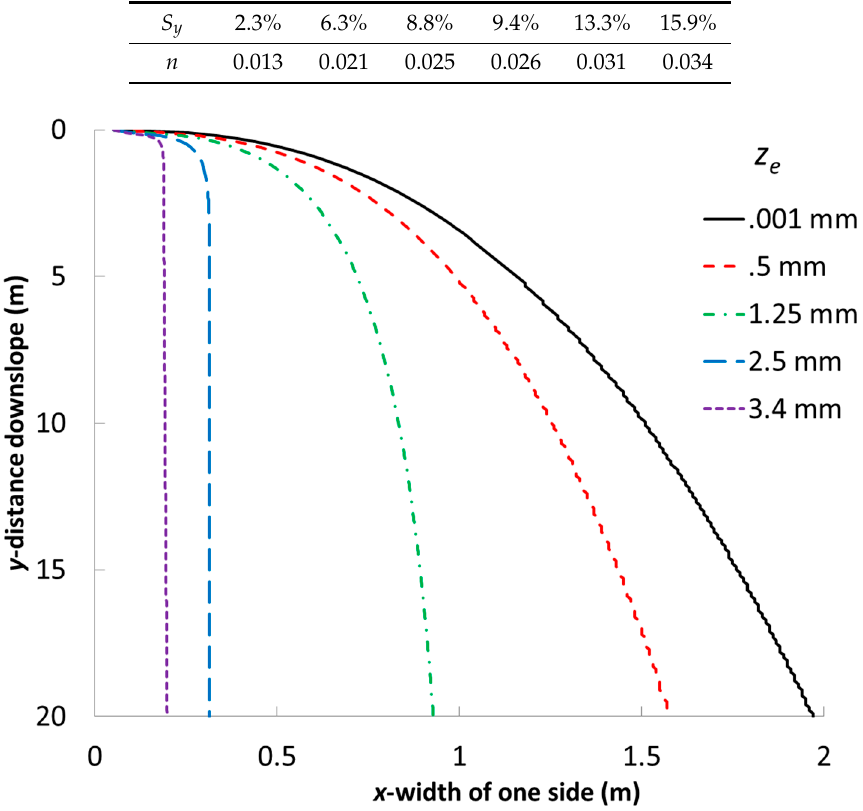
Table 1. Calculated n from S y for the roughened paint surface, based on Equation (14).